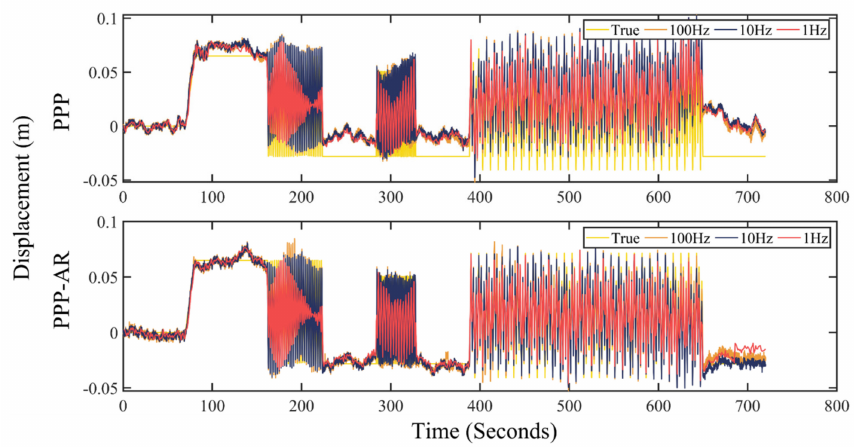
Figure A3. 100 Hz, 10 Hz and 1 Hz displacement time series corresponding to quasi-static and sinu- soidal motion derived from multi-GNSS observations with PPP and PPP-AR techniques, respectively.